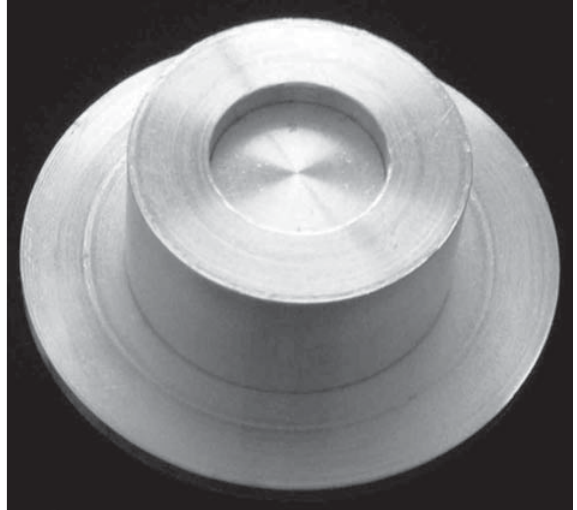
Figure 2- Molds obtained after inclusion of colorless acrylic resin disks in silicone and dental